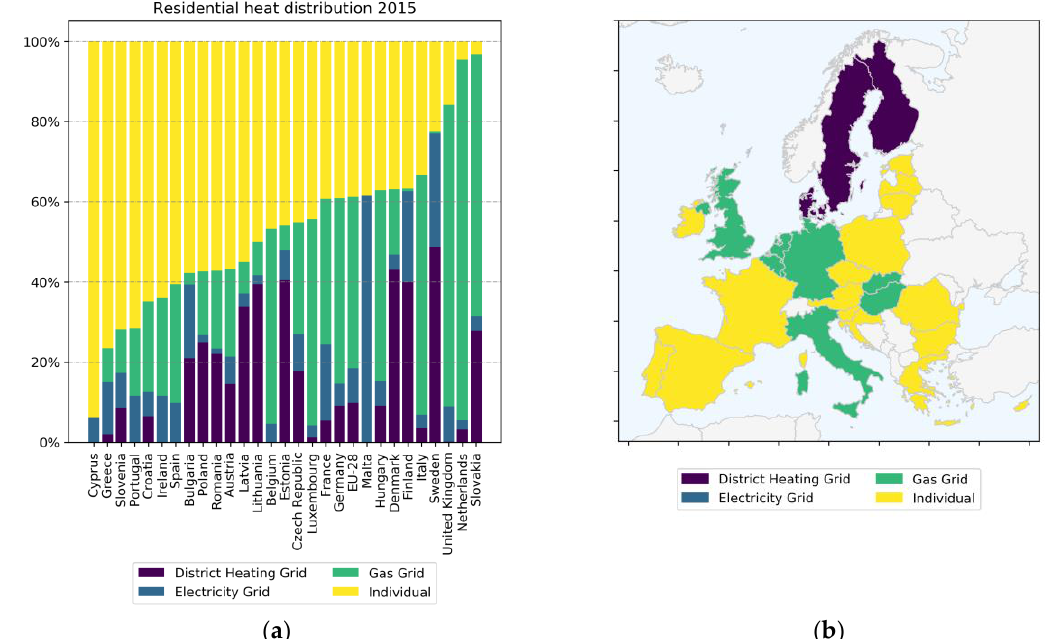
Figure 4. ( a ) Share of residential heat consumption from individual heating or delivered via district heat networks, gas grids or electricity grids per MS. ( b ) Geographical representation of the most used heat delivery infrastructure or individual heating per MS.